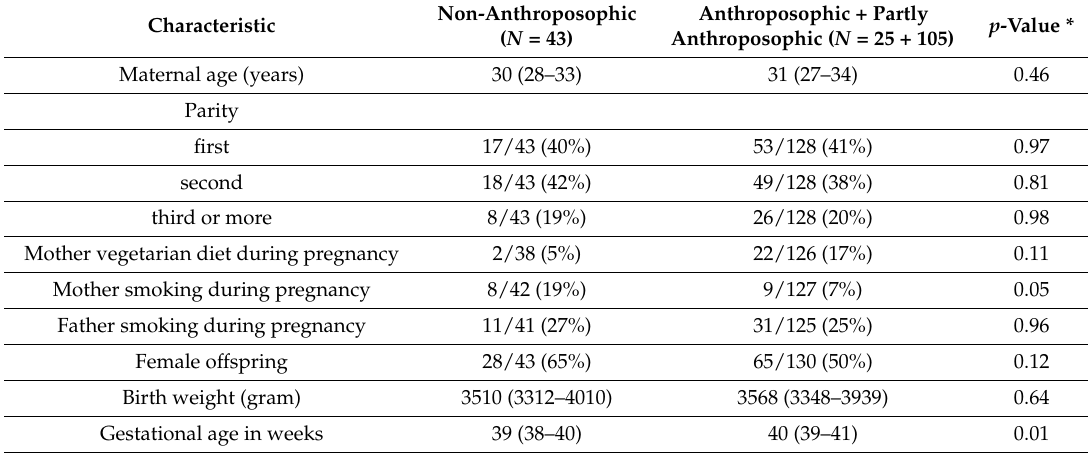
Table 1. Demographic data of participating families.